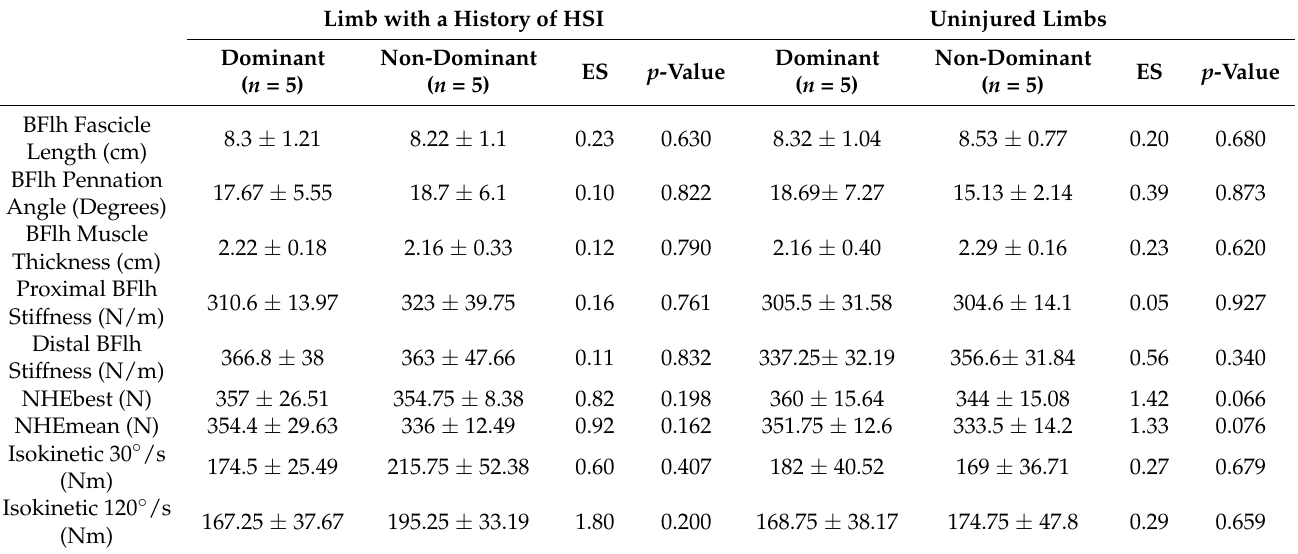
Table 3. Comparative data between injured dominant limb, injured non-dominant limb, uninjured dominant limb and uninjured non-dominant limb in previously injured players. Data are presented as mean ± SD. Limb with a History of HSI Uninjured